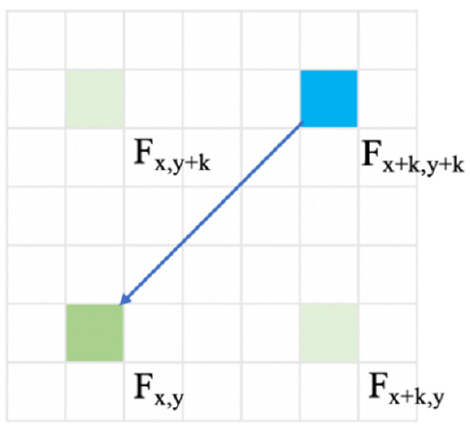
Figure 8. The relation information transference in Figure 8 . The relation information transference in RCCA .